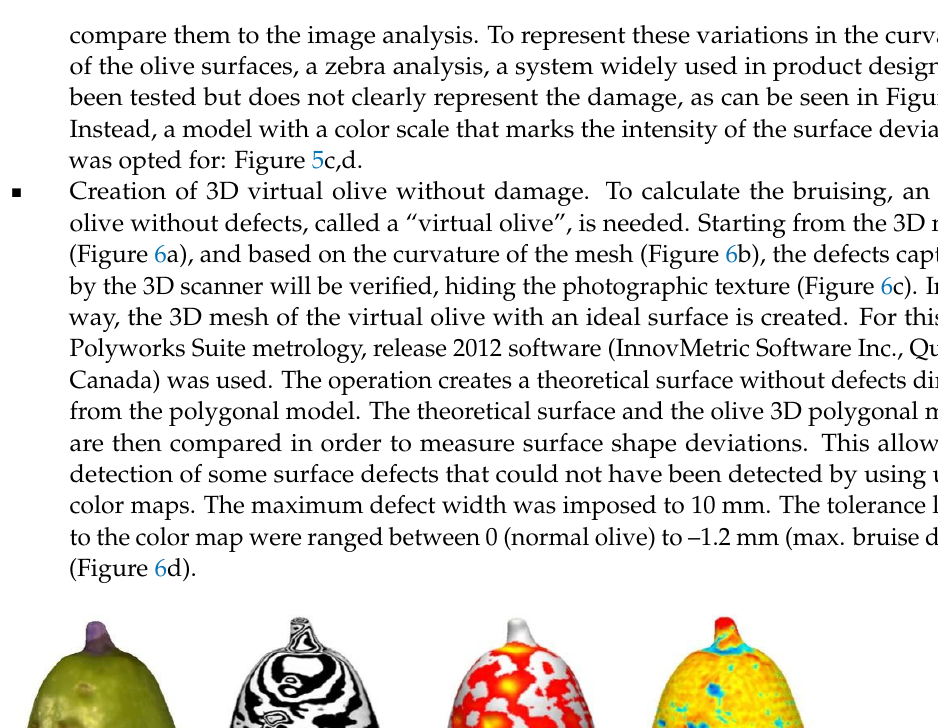
Table 3. Example of results obtained from scanning workflow.